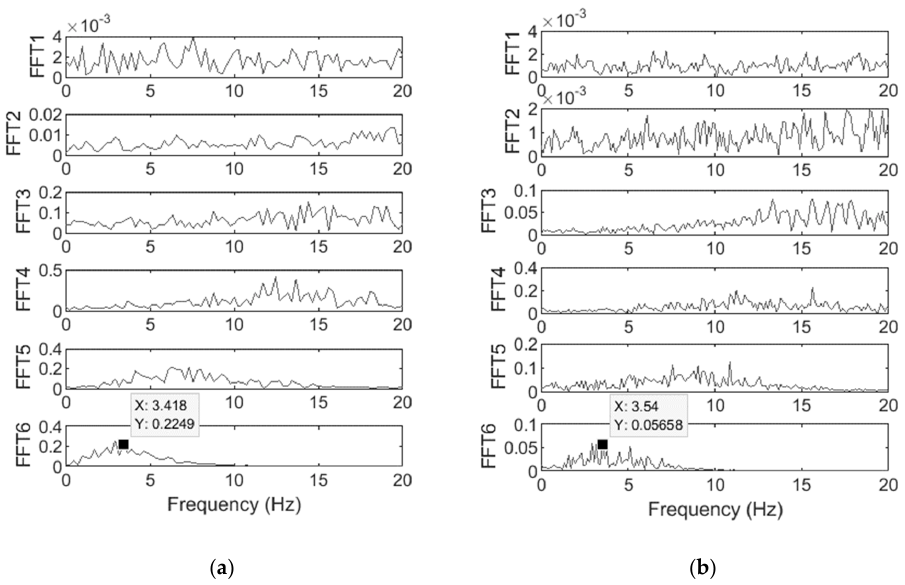
Figure 8. FFT of the IMFs of the vehicle acceleration response when the vehicle speed is ( a ) 10 m/s and ( b ) 5 m/s. ( b ) 5 m /